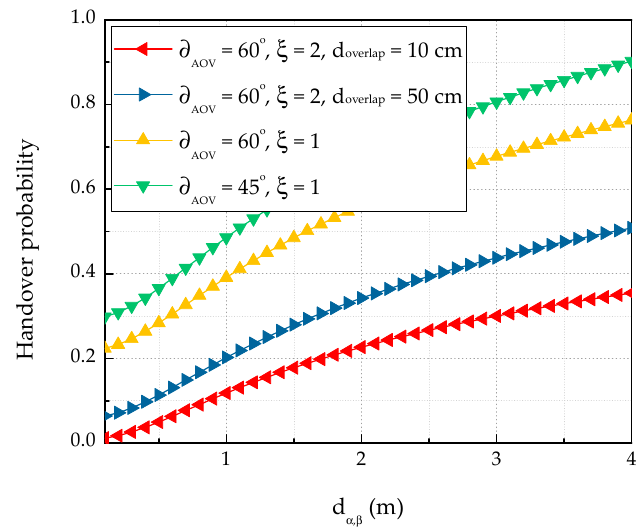
∂ and ξ . Figure 9. OCC-to-BLE handover probability versus LED-to-camera distance for various ∂ ξ . AOV and AOV